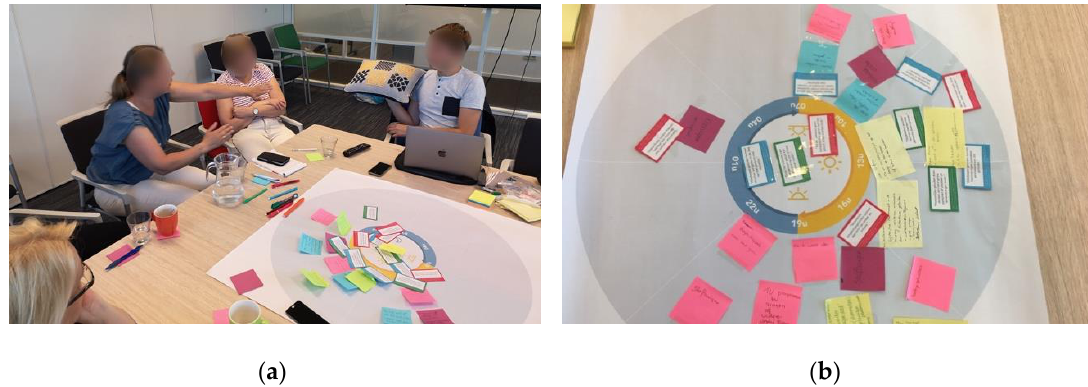
Figure 4. Lastly, the professional caregivers were asked to develop concrete use-cases for Vita: ( a ) The researcher explained the design rationale of Vita. ( b ) The professional caregivers were asked to think of specific cases to use Vita, which was then discussed during the final group discussion.